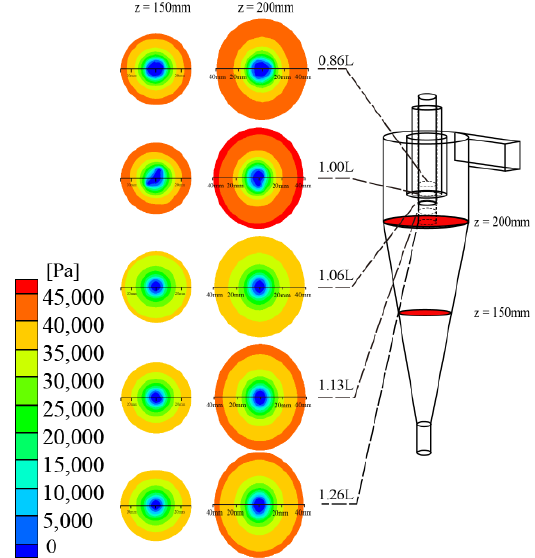
Figure 11. Influence of the insertion depth of the internal overflow pipe on the pressure.